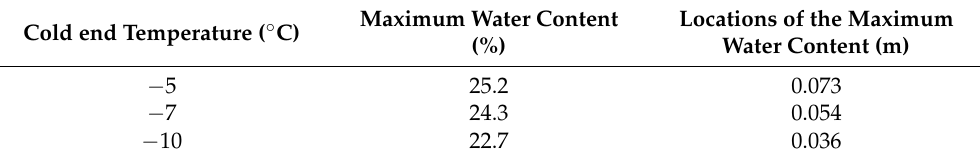
Table 4. The maximum water content and its corresponding location in the